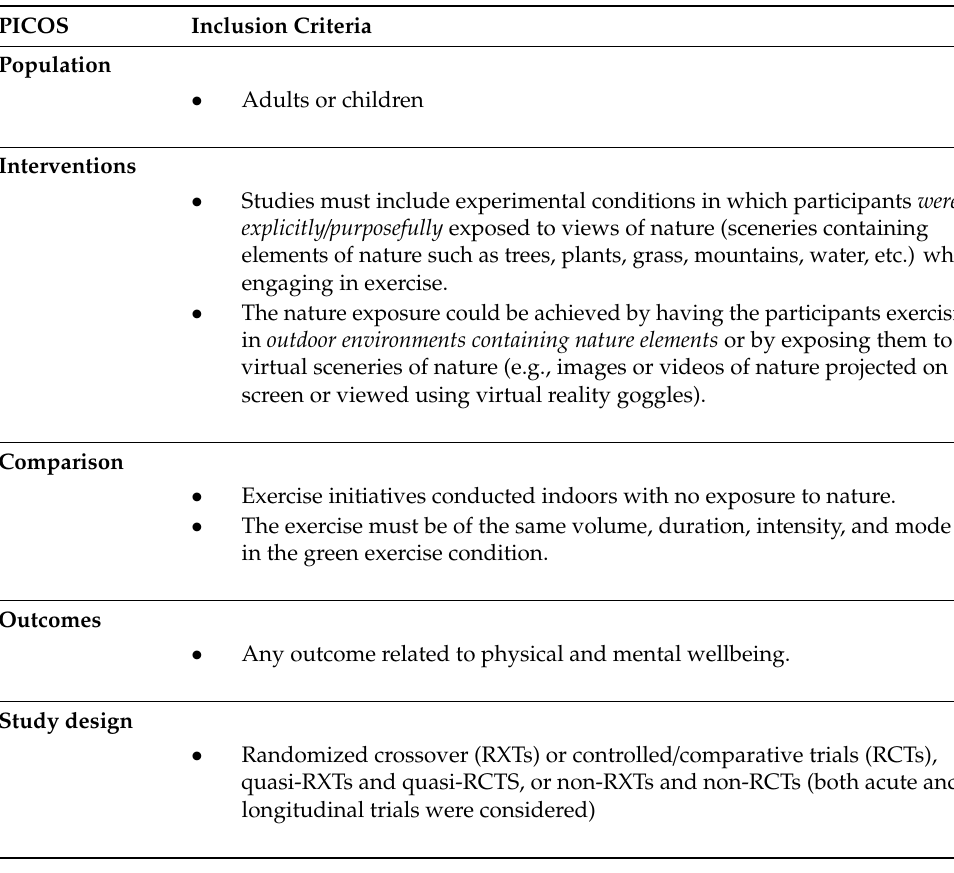
Table 2. Green exercise review eligibility